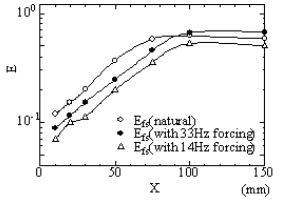
Fig. 21 Streamwise growth of integrated starting vortex fs component in the initial stage of